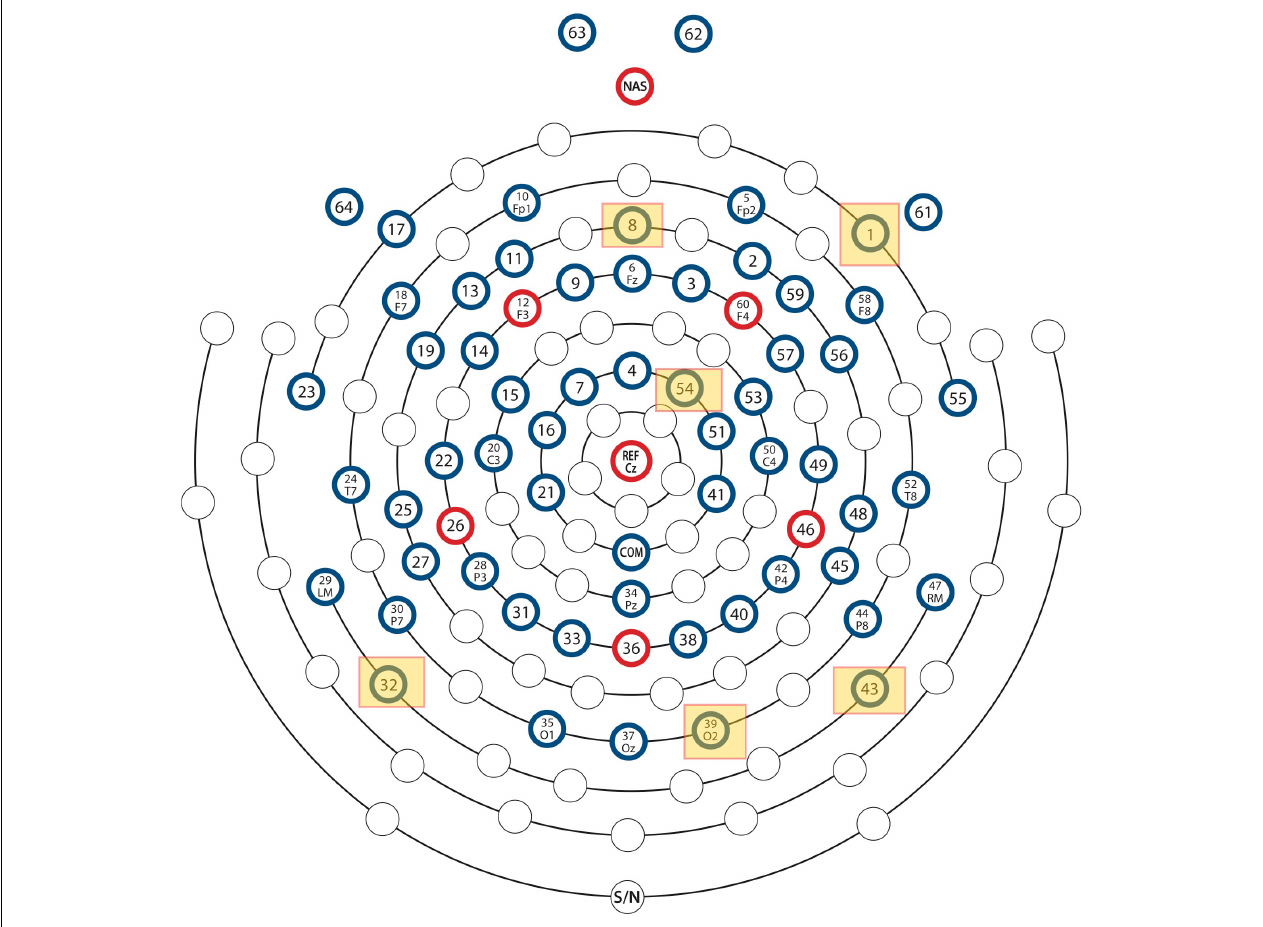
FIGURE 1 | Locations of the EEG electrodes on the scalp. The locations of the six most important channels with respect to classification performance of the neural network are marked by yellow